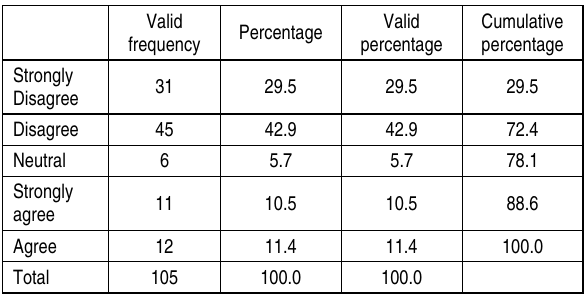
Table 6. Levels of innovation in South